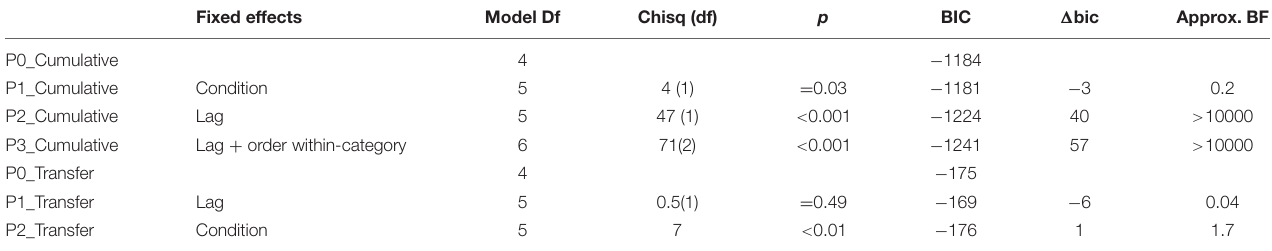
TABLE 3 | The fit indices on the analysis with picture trials.